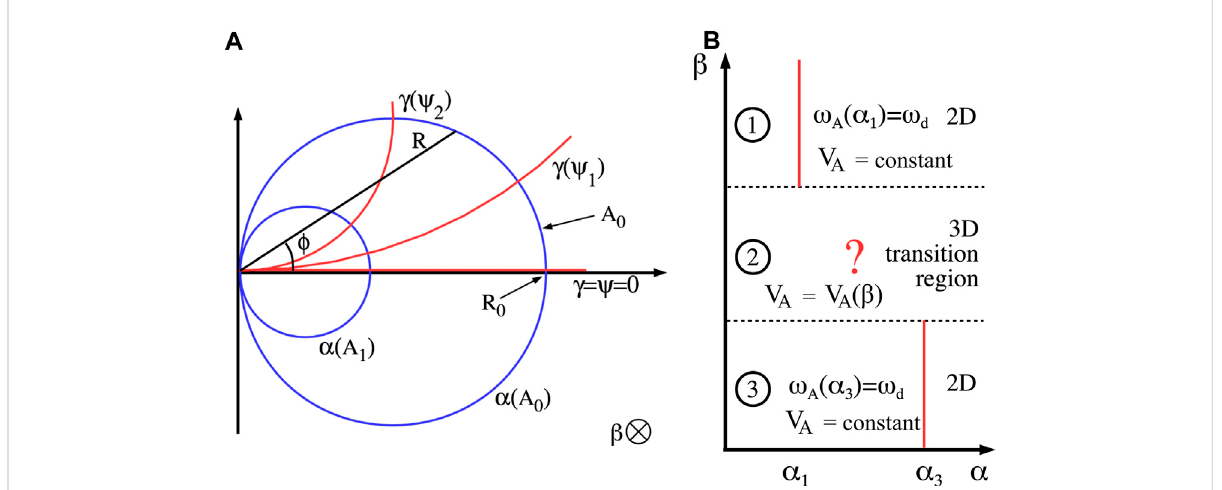
FIGURE 2 (A) Schematic in a meridian plane of the 2-D dipole coordinates ( α , β , γ )used in the model (Figure 2, Wright and Elsden (2016)). (B) View looking down on the equatorial plane of the 2-D dipole, considering how the resonance location might vary for a medium which varies with azimuth ( β ), further explained in the main text (Figure 1, Wright and Elsden